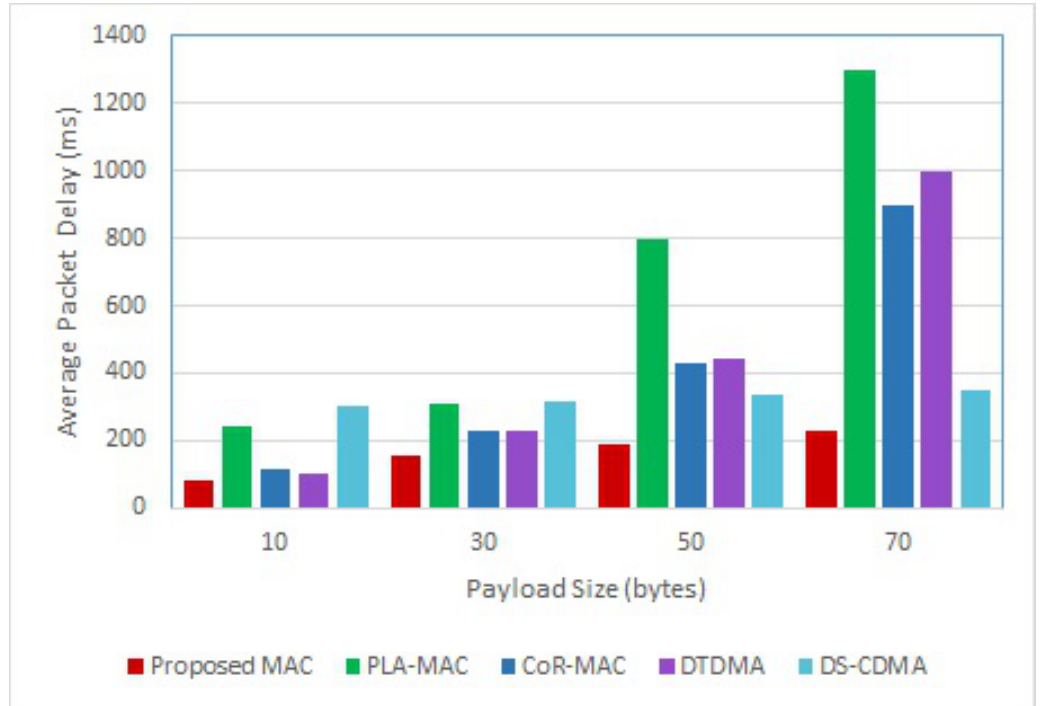
Figure 7. Delay Performance for Varying Payload Size.